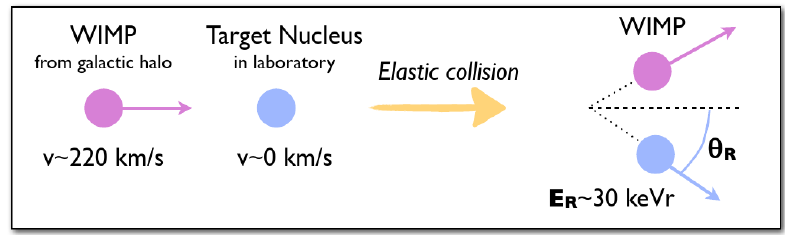
Figure 2: A schematic of dark matter (WIMP) elastic scattering off a target